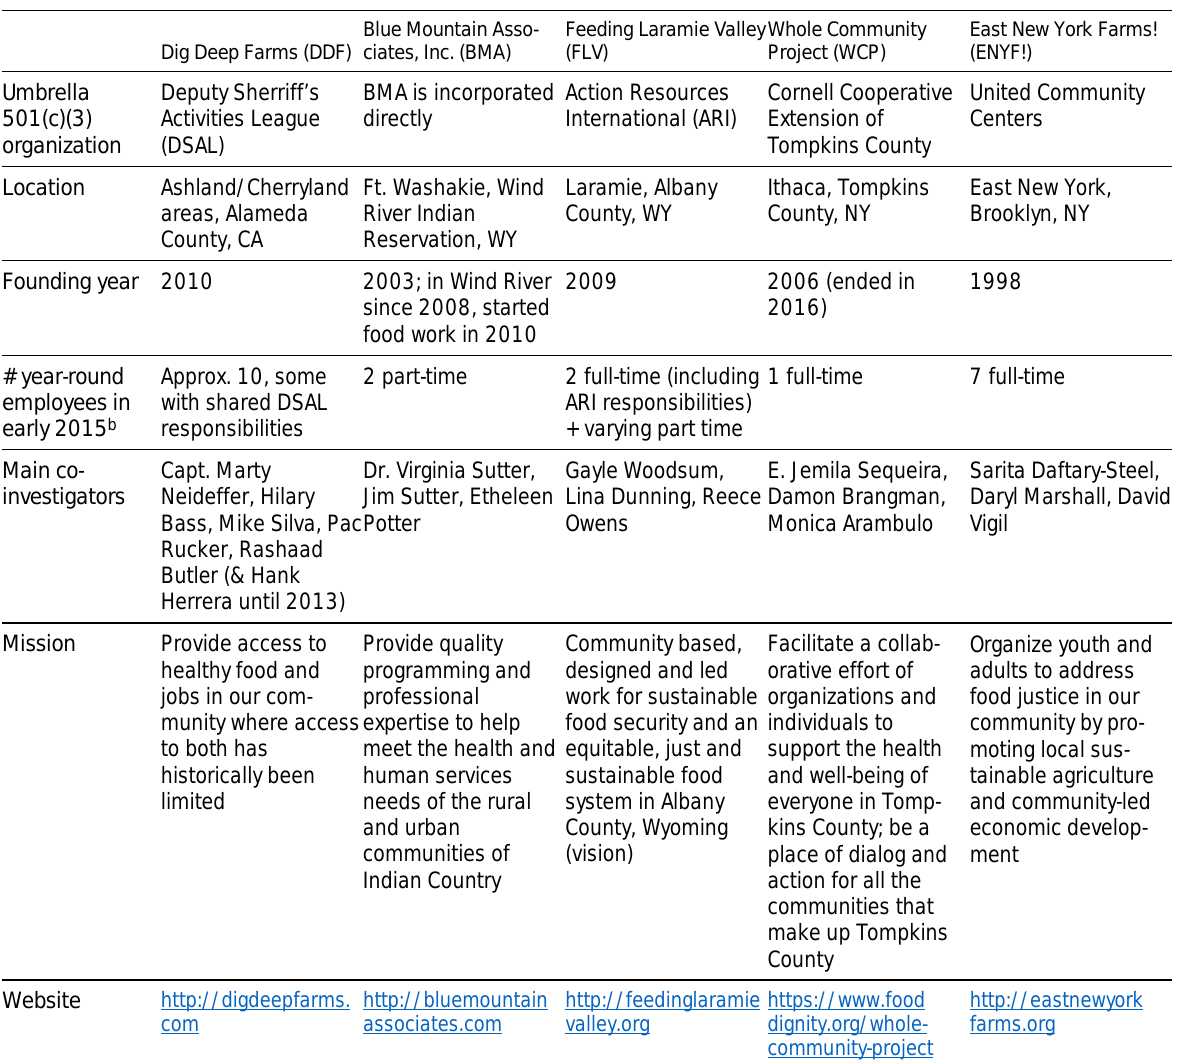
Table 1. Summary Characteristics of the Food Justice CBO Partners a in Food